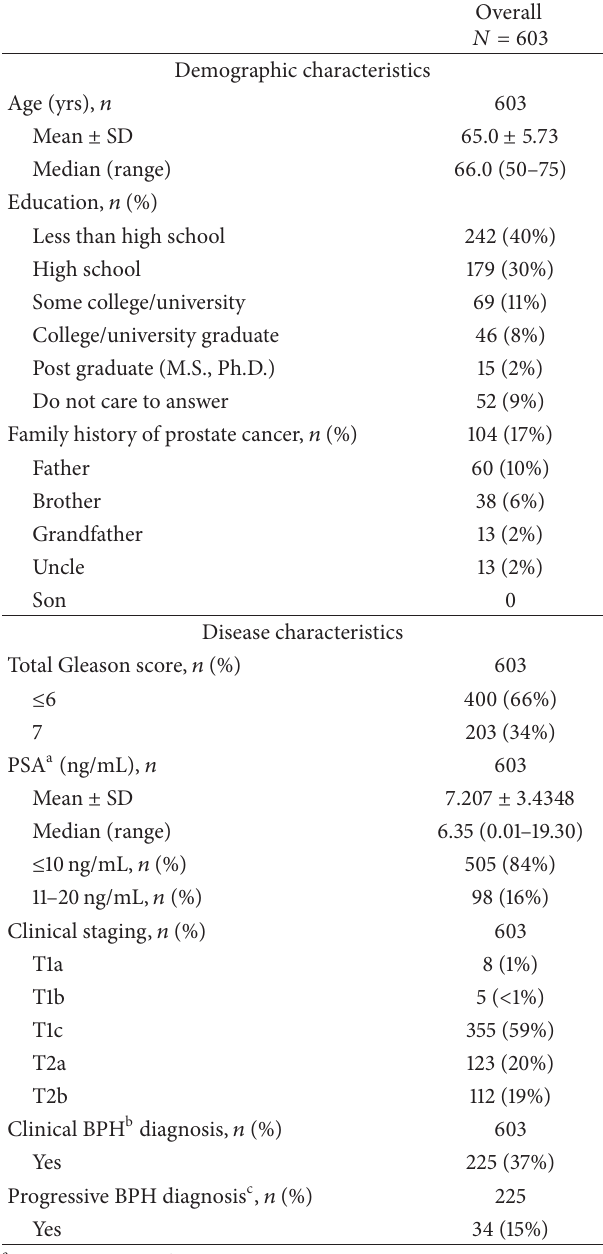
a PSA: prostate-specific antigen. b BPH: benign prostatic hyperplasia. c Defined by acute urinary retention (AUR) and BPH-related